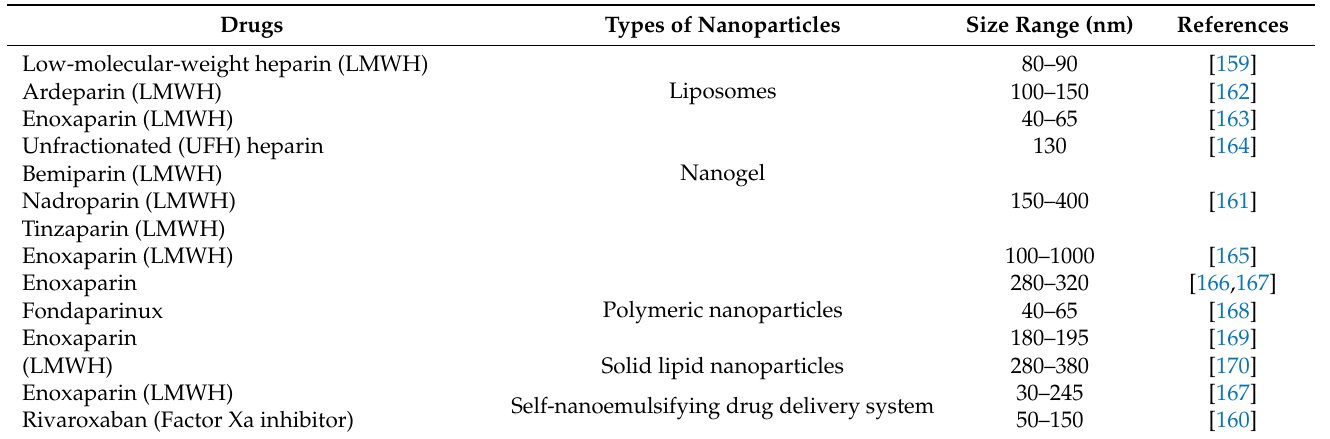
Table 2. Nanoparticles loaded with anticoagulant therapies using different drug delivery